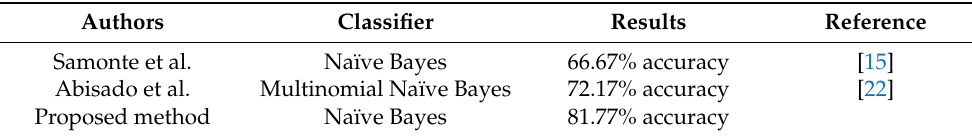
Table 2. Comparison of Philippine tweet classification results using RM and Naïve Bayes classifier